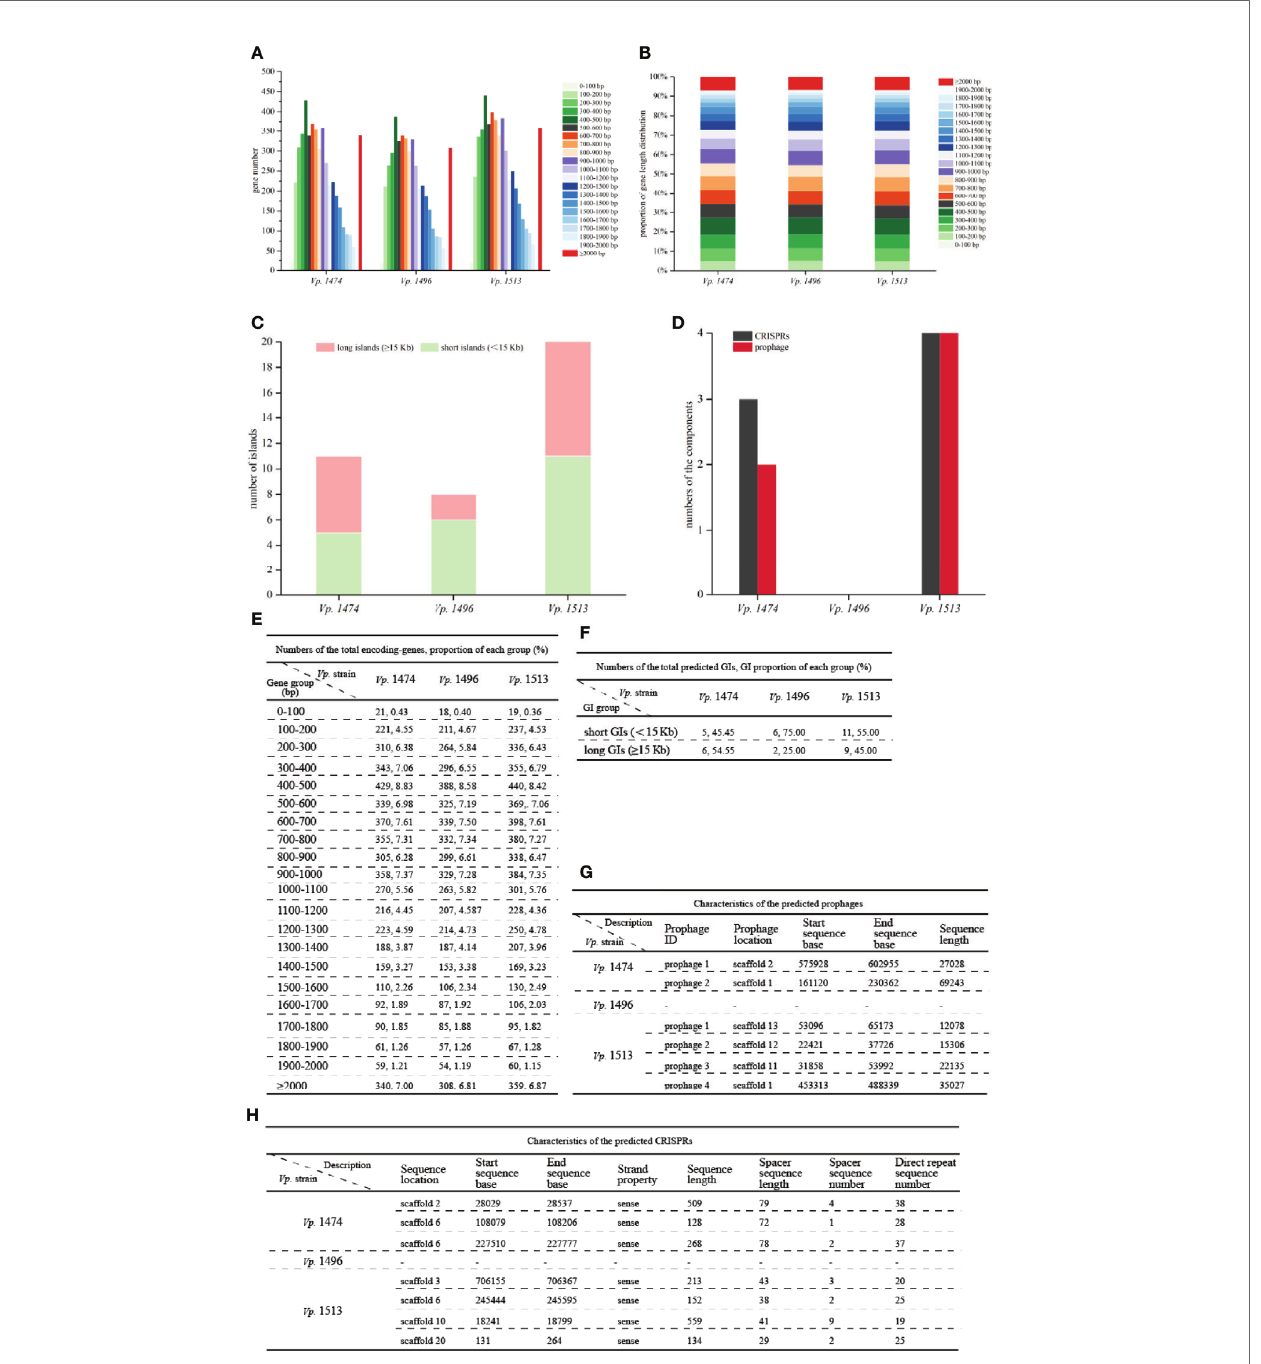
FIGURE 2 | General genome components analysis of V. parahaemolyticus strains Vp . 1474, Vp . 1496, and Vp . 1513. (A) Statistical histogram of coding gene length distribution for the three strains. Coding gene zones were measured as 0 to 400 bp, 400 to 1,000 bp, 1,000 to 2,000 bp, and longer than 2000 bp as groups of short genes, medium long genes, long genes, and very long genes, respectively. (B) Percentage accumulative bar diagram of coding gene length distribution for the three strains. Coding gene zones were measured in 100 bp; 0 to 400 bp, 400 to 1,000 bp, 1,000 to 2,000 bp and longer than 2000 bp as groups of short genes, medium long genes, long genes and very long genes, respectively. (C) Accumulative bar diagram of genomic islands (GIs) for the three strains. GIs were divided into long islands and short islands by the length of 15 kb. (D) Statistical histogram of CRISPRs and prophages for the three selected strains. The component numbers of CRISPRs or prophages are shown on the Y-axis. (E) Statistical data of coding gene length distribution for the three strains. (F) Statistical data of GIs for the three strains. (G) Detailed characteristics of the predicted prophages for the three strains. (H) Detailed characteristics of the predicted CRISPRs for the three